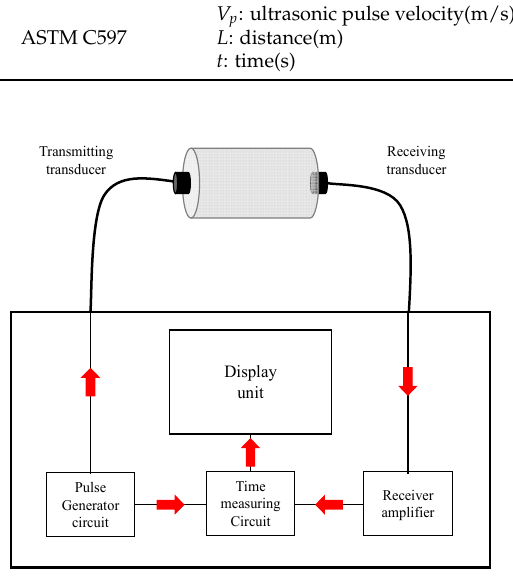
Figure 5. Ultrasonic pulse velocity test. Table 5. Testing of residual mechanical properties.